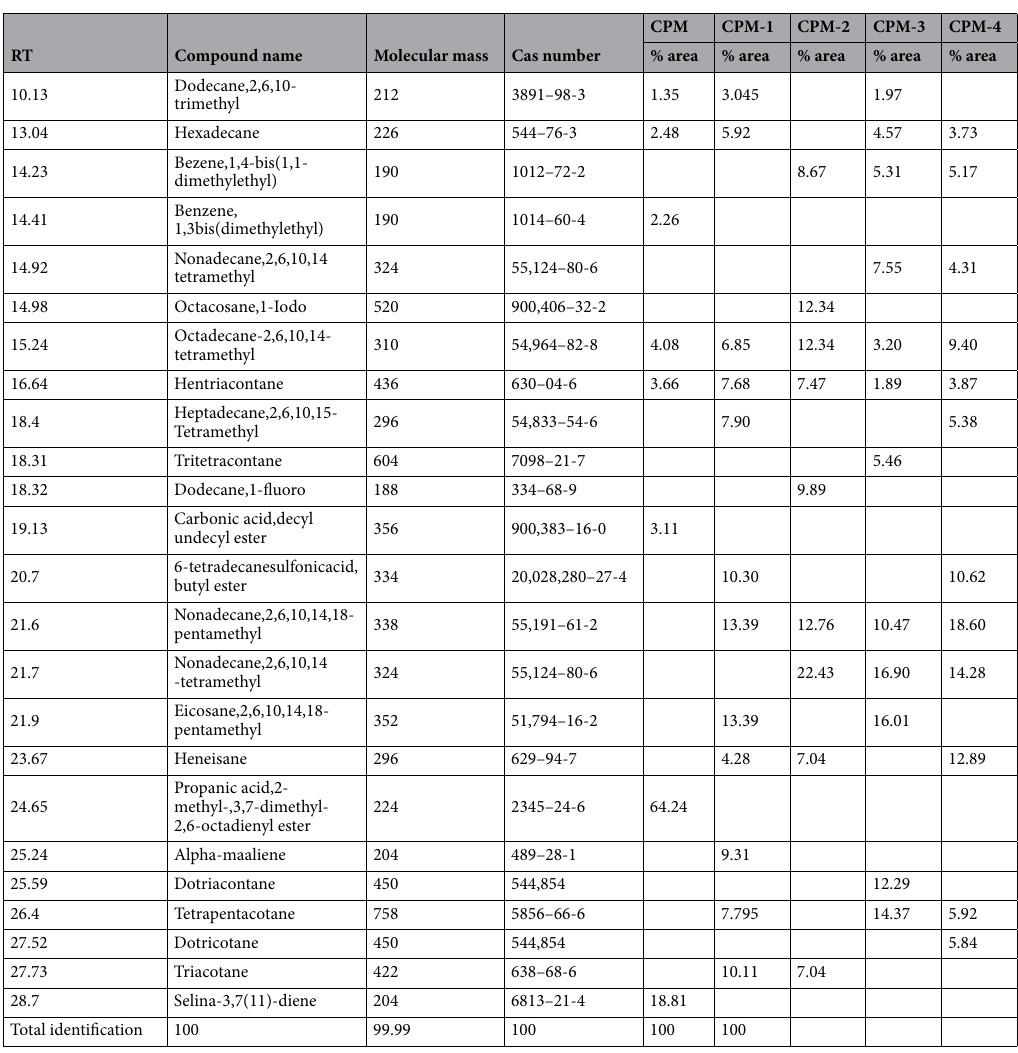
Table 6. Phytocomponents identified in ethyl acetate extract of S. costus callus grown on simple callus promoting media (Kinetin: 0.5mgL -1 and 2.4-D: 1.0 mgL -1 ) and callus subjected to various stresses i.e. 60gL -1 Sucrose